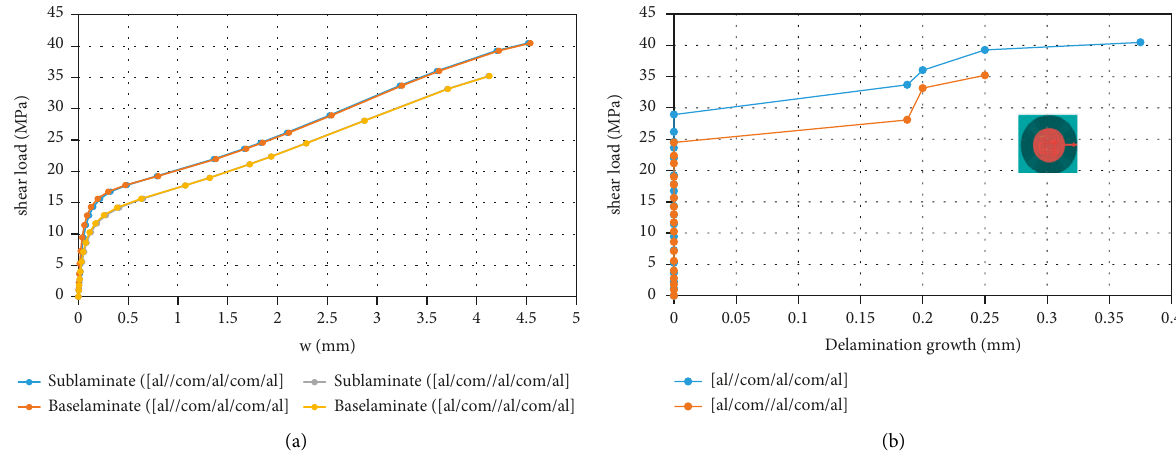
Figure 9: (a) Postbuckling behaviour of GALRE 3-3/2-0.3 and (b) delamination growth of GALRE 3-3/2-0.3.